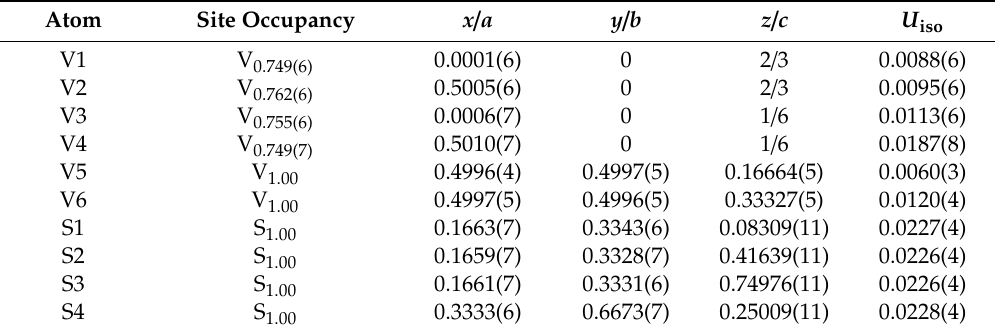
Table 3. Atoms, site occupancy, fractional atom coordinates (Å), and isotropic atomic displacement parameters (Å 2 ) for eliopoulosite.